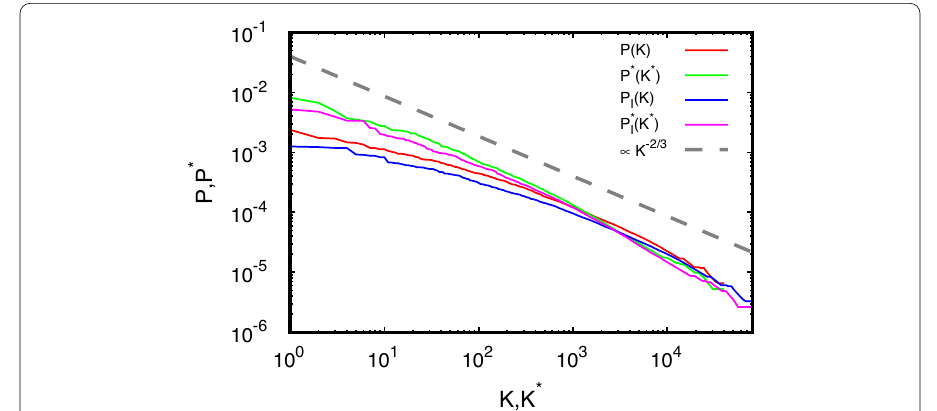
Fig. 1 PageRank probability P ( K ) ( P I ( K ) ) and CheiRank probability P ∗ ( K ∗ ) ( P ∗ I ( K ) ) are shown as a function of the corresponding rank indexes K and K ∗ for the simple (Ising) MetaCore network. For comparison, the dashed gray line corresponds to the power decay P ∝ K − 2 /